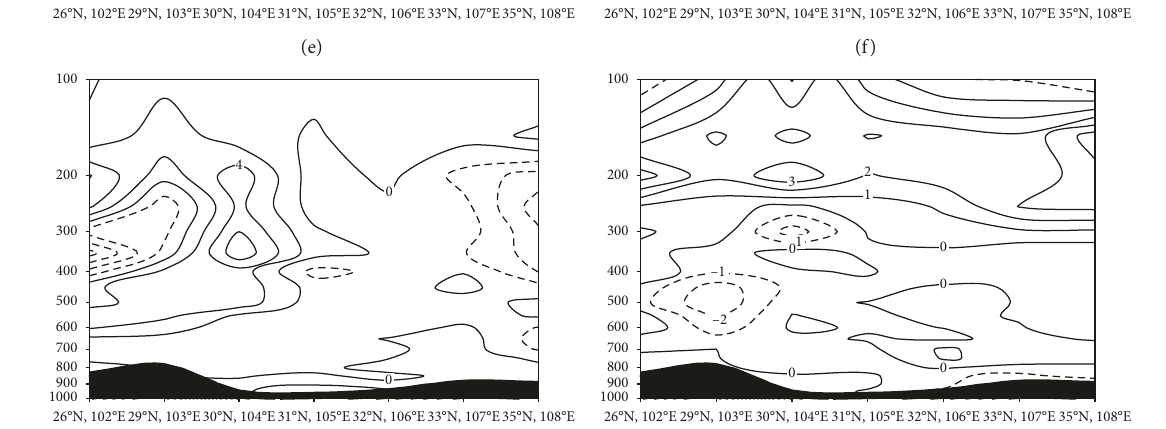
in Figure 6(a) (black area is the ′